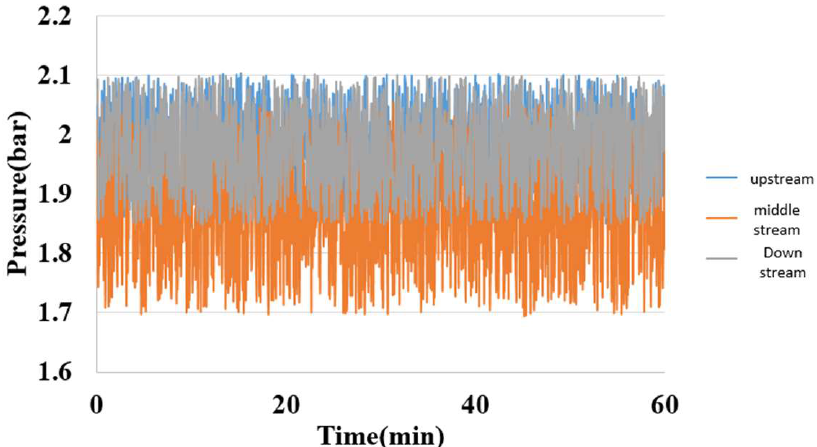
Figure 21. Internal pressure distribution of the hydrogen/vanadium redox battery.